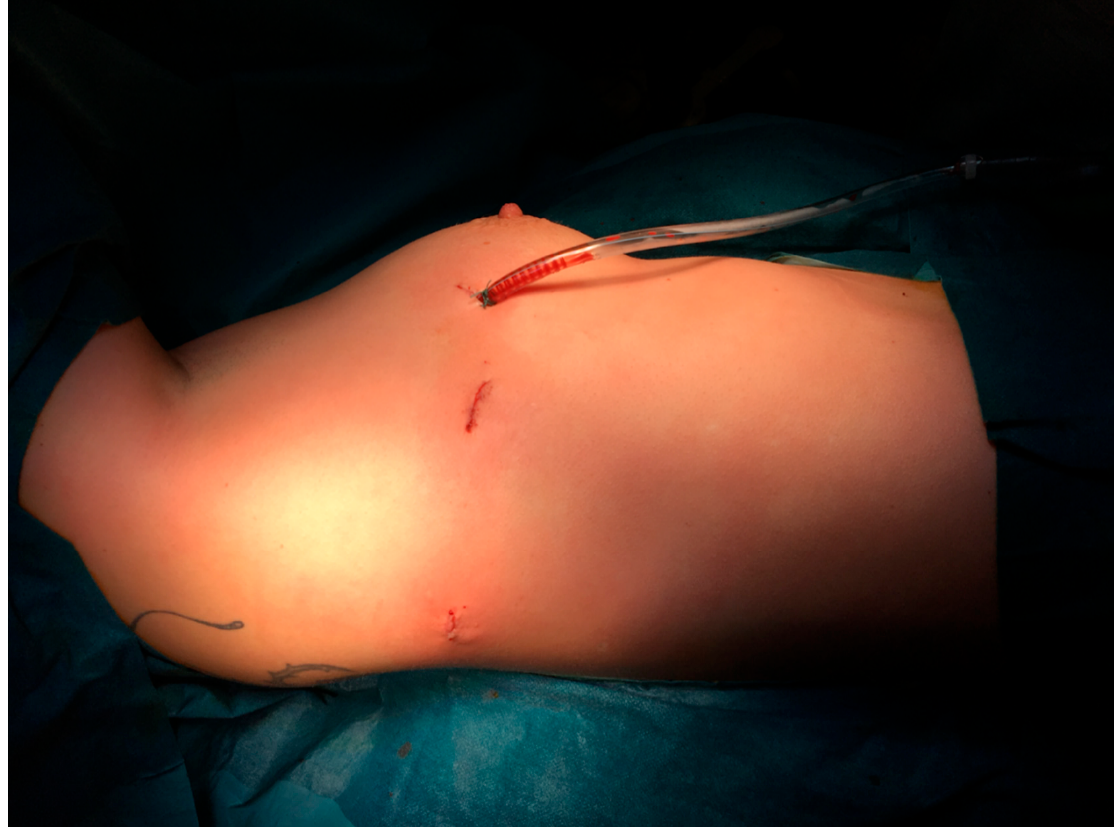
Figure 1. Completely portal approach using only three incisions; extraction through ventral port (drain indwelling).